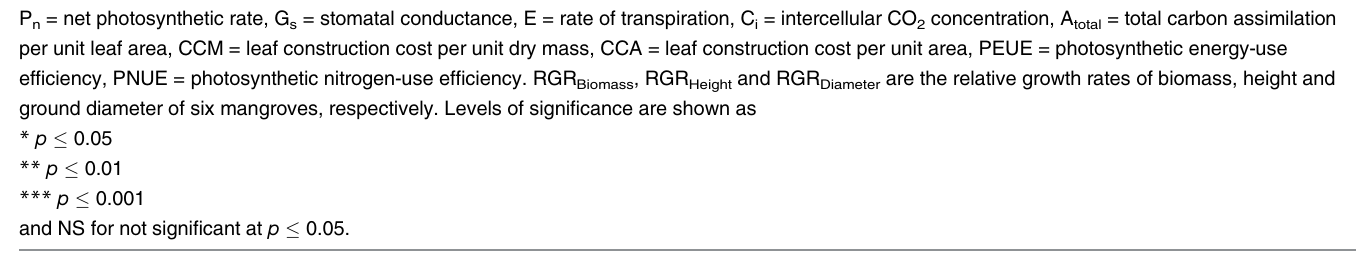
P n = net photosynthetic rate, G s = stomatal conductance, E = rate of transpiration, C i = intercellular CO 2 concentration, A total = total carbon